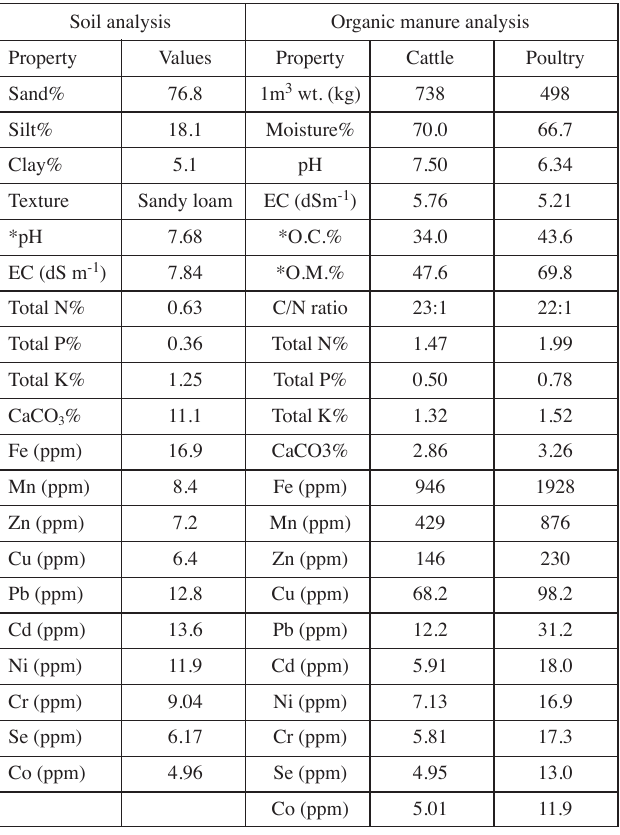
Tab. 1: Physical and chemical properties of experimental soil, organic manures and irrigation water. Soil analysis